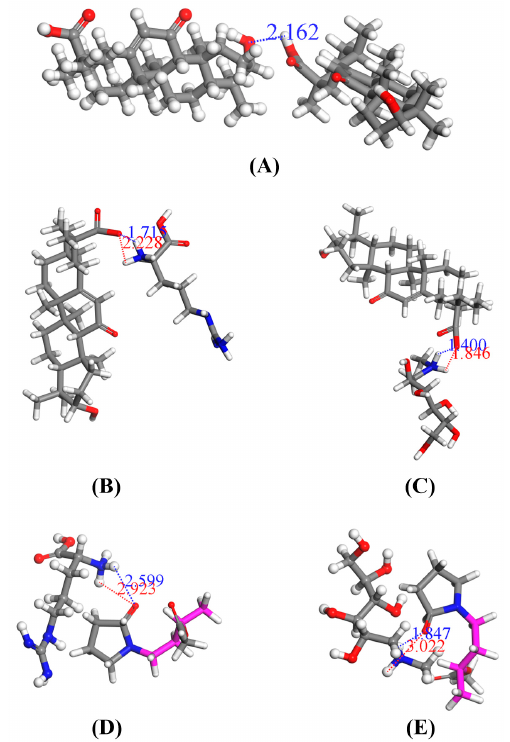
Figure 11. Optimal molecular docking conformation. ( A ) GA with GA, ( B ) GAH¯ with MGH + , ( C ) GAH¯ with LAH + , ( D ) Kollidon ® VA64 with MGH + , and ( E ) Kollidon ® VA64 with LAH + .